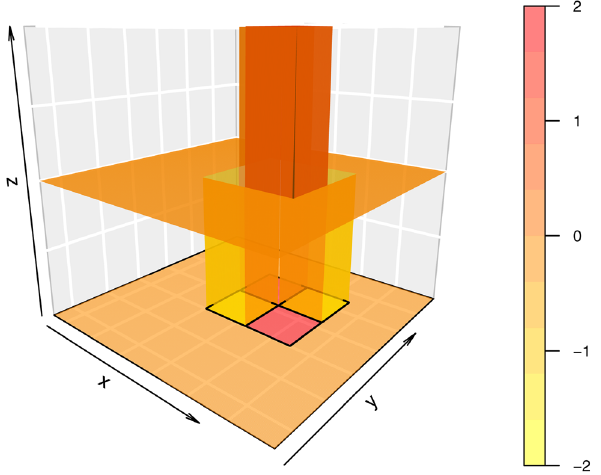
km j ,, for = = n m 1 and = = k j 0 generated using a grid of 300 × 300 points over the rectangle n